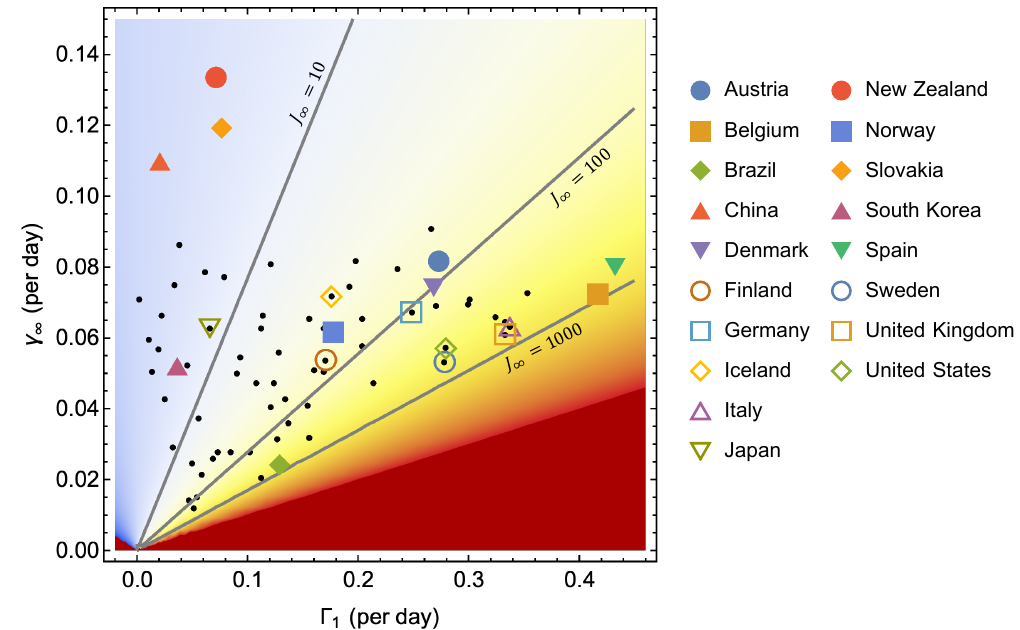
Figure 6. Density plot of J ∞ ( Γ 1 , γ ∞ ) with some isolines marked, along with the points for 73 countries. The legend shows the positions for some selected